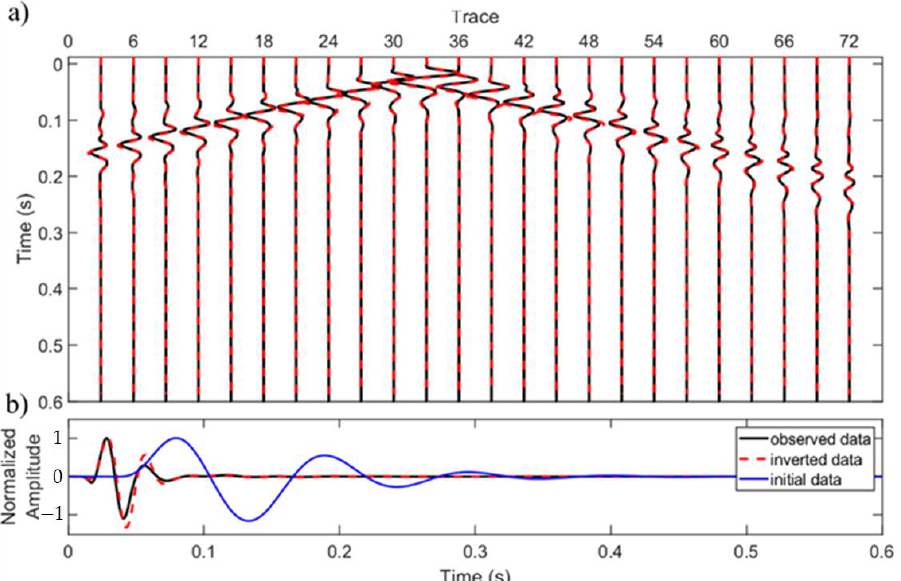
Figure 5. Fitting of the data in the shot at x = 9 m when using a low-frequency source signal. ( a ) Comparison of the vertical velocity observed and inverted seismograms. ( b ) Comparison of the normalized seismograms calculated for the initial, inverted, and observed data for trace 36.